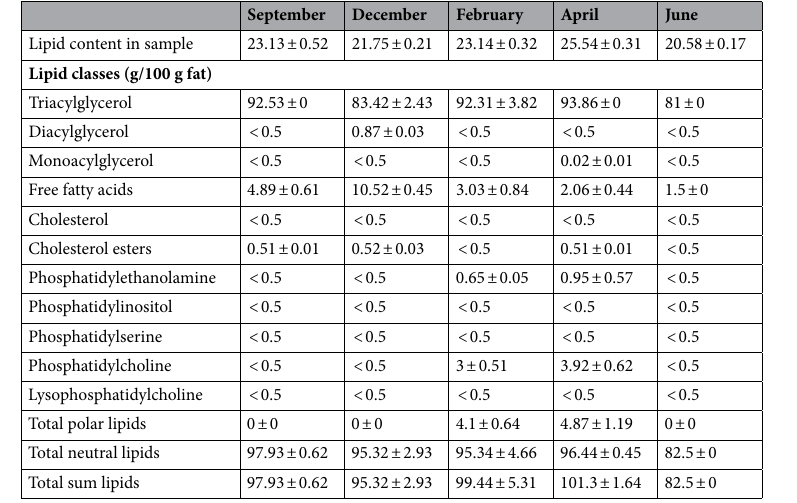
Table 4. Seasonal variations in lipid class composition of hepatopancreas (n =